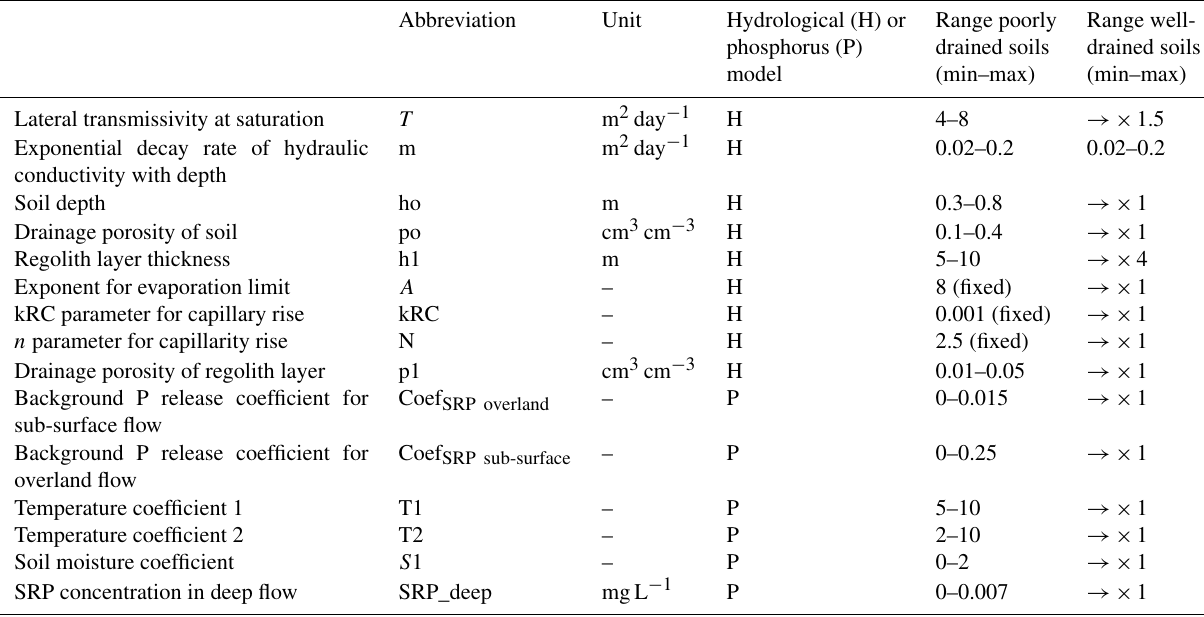
Table 1. Initial parameter ranges in the hydrological and soil phosphorus